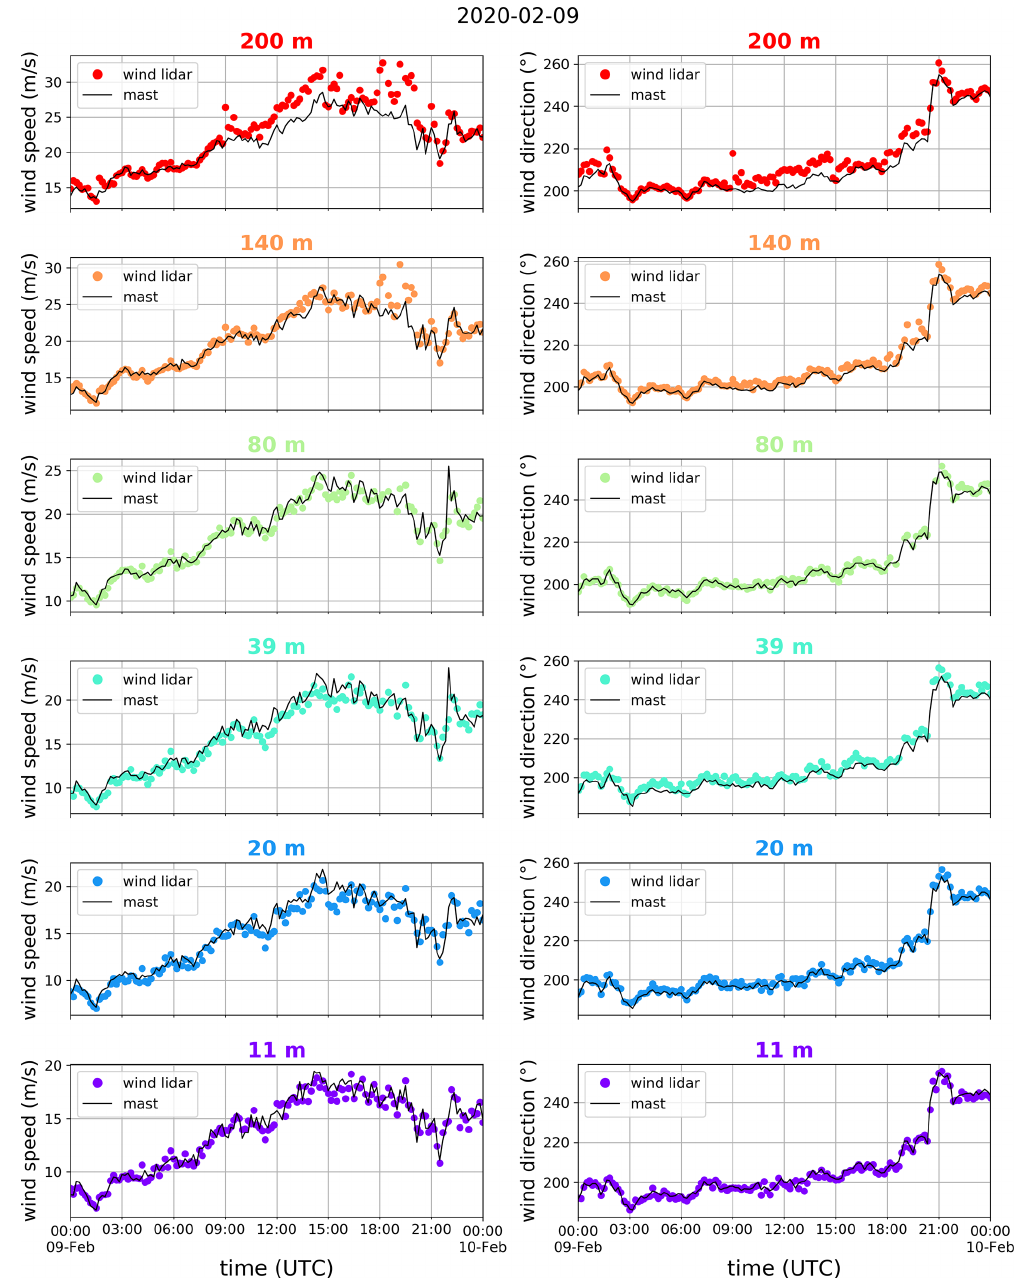
Figure 4. Wind measurements of 9 February 2020 (storm Ciara), comparing the 10min averaged data of the mast (solid black lines) and the wind lidar (coloured symbols), showing wind speed (left) and wind direction (right) for different heights (indicated at the top of each panel).